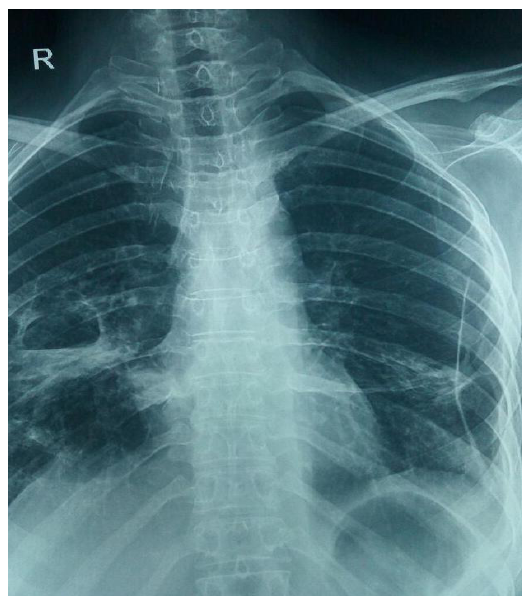
Figure 4 . Follow up chest x ray of patient showing resolution of lesions .left sided pneumothorax is also